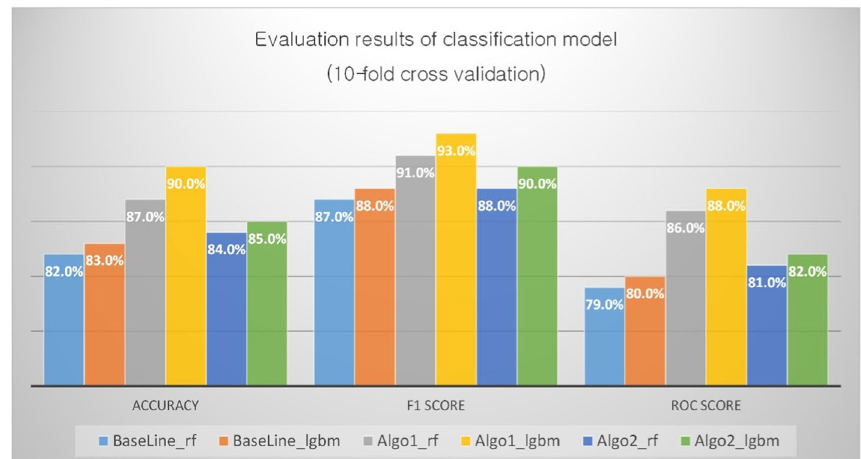
Fig. 13 Evaluation results of classification models—3 algorithms in RF vs.